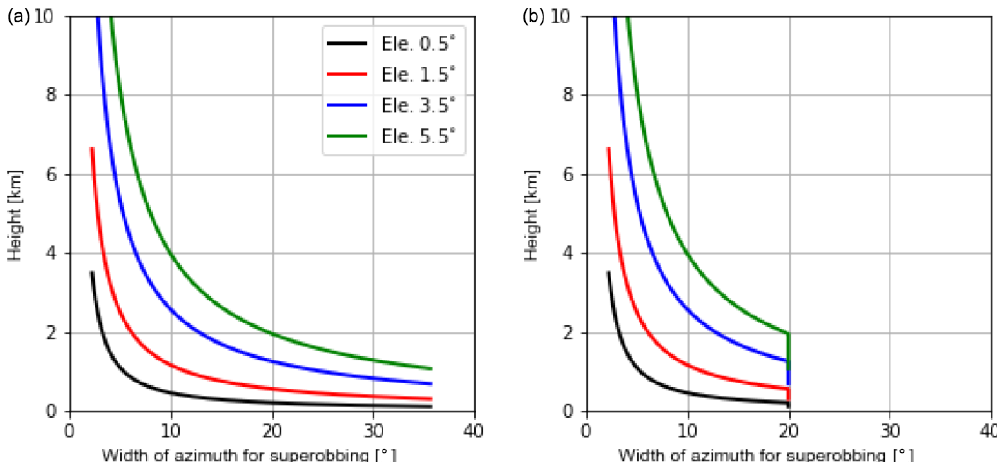
Figure A4. Variations of the width of azimuth with height for superobbing of reflectivity (a) and radial wind (b) at elevations of 0 . 5, 1 . 5, 3 . 5 and 5 . 5 ◦ . A maximum of 20 ◦ is set for superobbing of radial